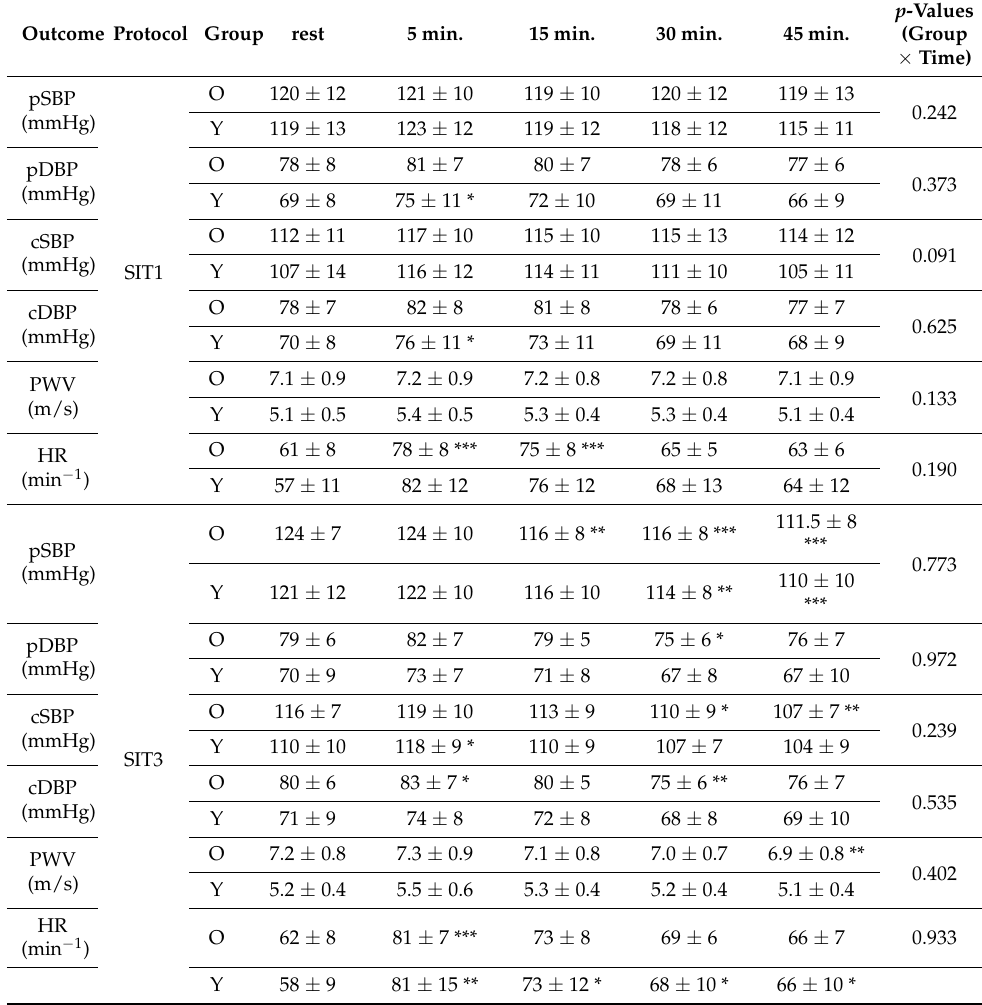
Table 2. Hemodynamic parameters at rest before (rest) and 5, 15, 30, and 45 min after the two sprint interval training protocols in groups of younger (Y) and older (O) adults. Outcome Protocol Group rest 5